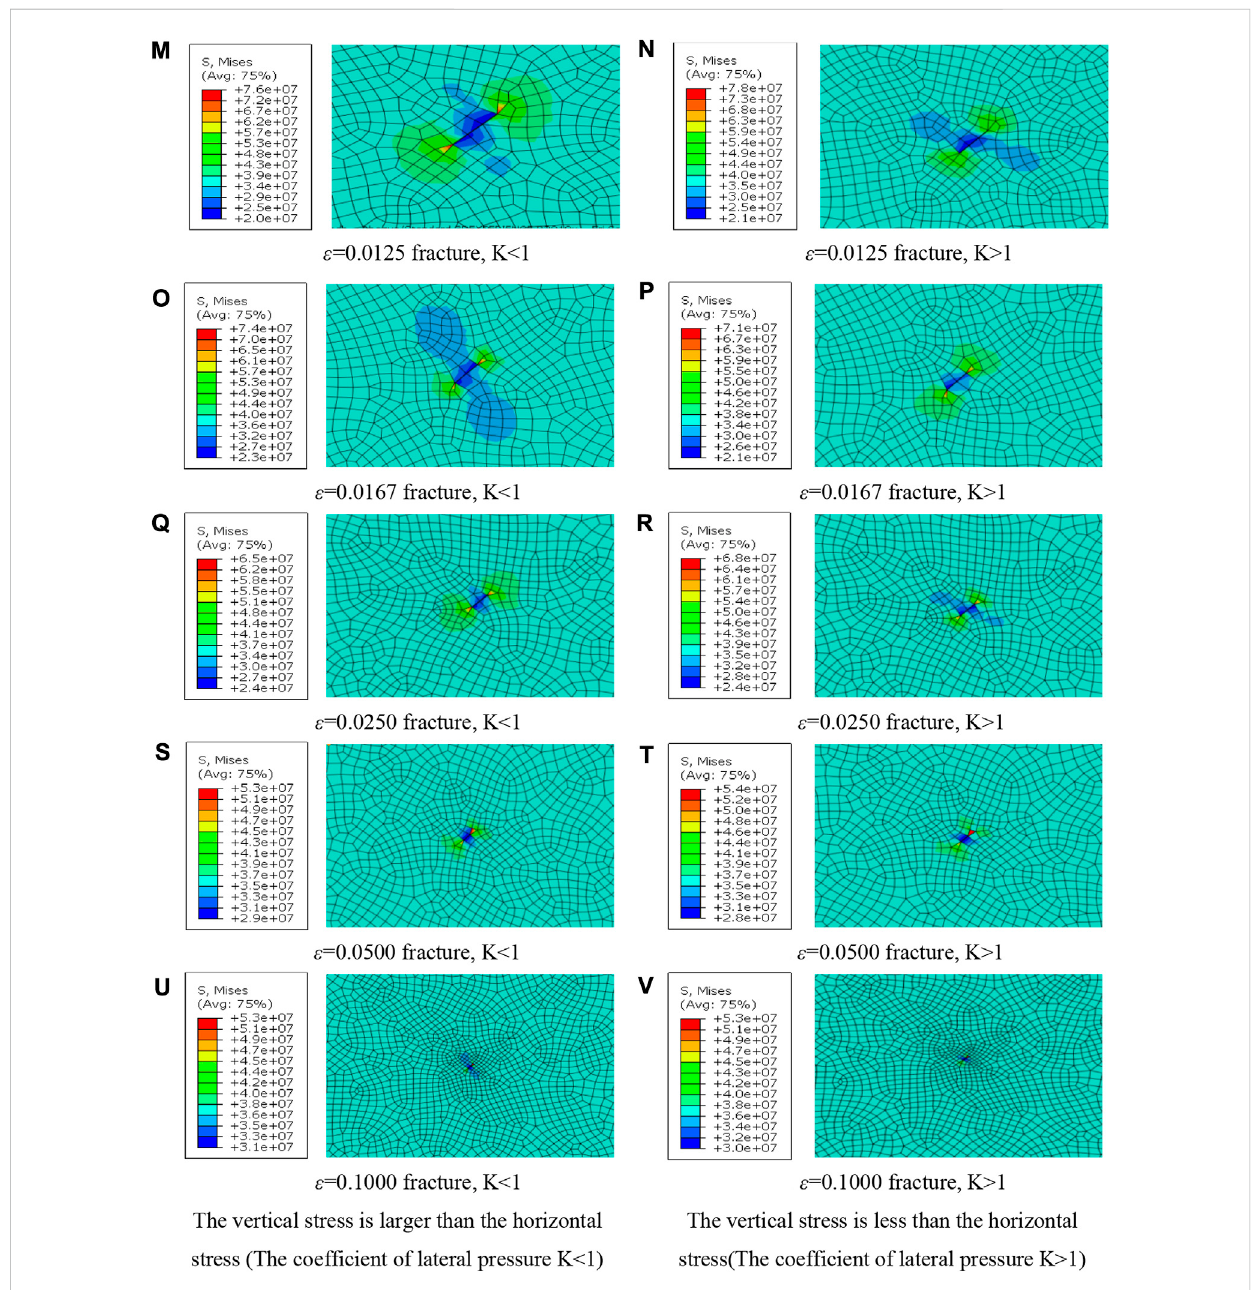
the vertical stress component applied to the fracture with a large angle is smaller than that of a slight dip angle. On the contrary, when the vertical stress is less than the horizontal stress, the vertical stress component applied to the fracture with a large angle is greater than that of a slight angle. The results of numerical simulation and theoretical prediction are in good agreement, which veri fi es the accuracy and practicability of the predicting model for fracture deformation based on different angles, and can be further used to deduce the natural fracture network deformation and productivity